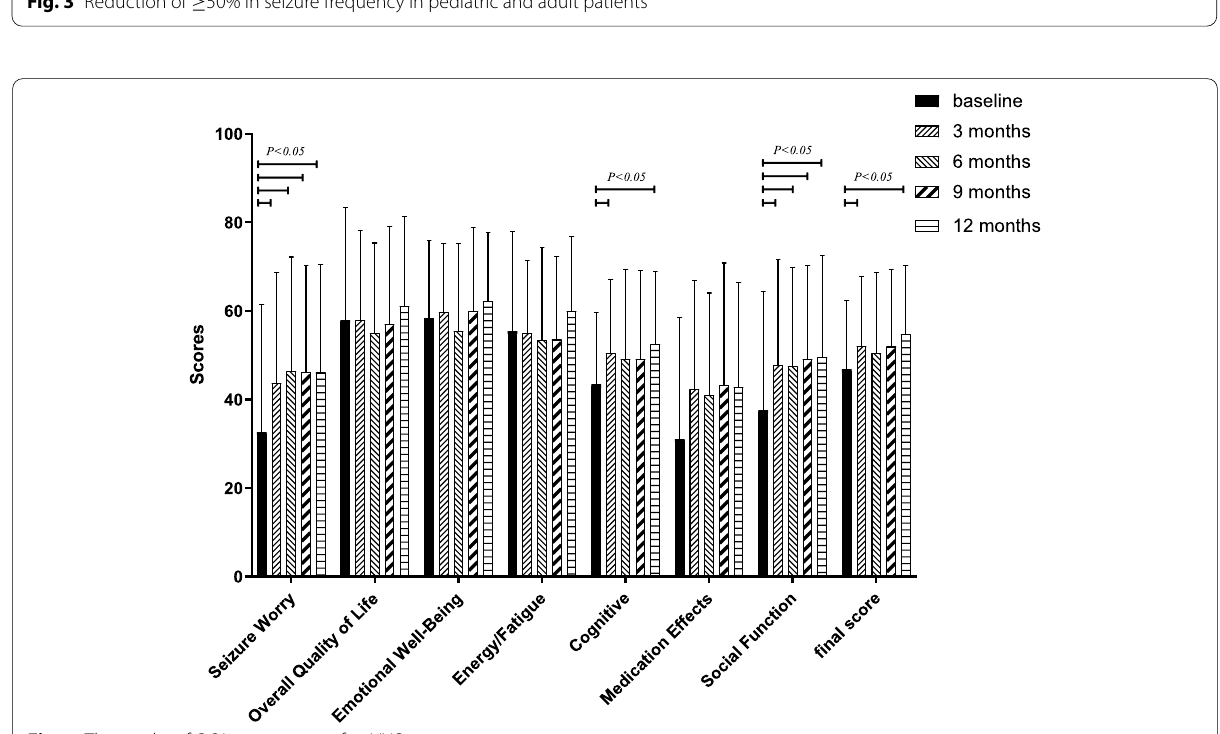
Fig. 4 The results of QOL assessment after